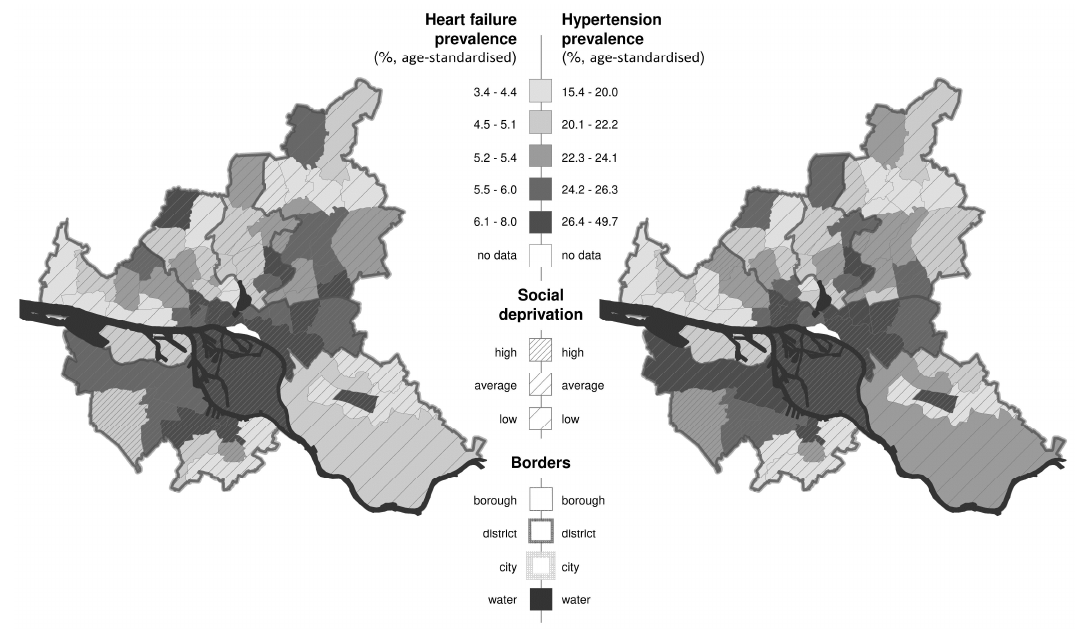
Figure 2. Prevalence rates of heart failure and hypertension, and spatial distribution of the variable “social deprivation” per borough, Hamburg, Germany, 2011. Age-adjusted overall treatment prevalence, including both sexes. Population is all the statutory health insured patients, with at least one contact to a contract physician working in the ambulatory sector per year. Classification of prevalence rates was conducted using quantiles. The variable “social deprivation” was obtained from a previously conducted PCA